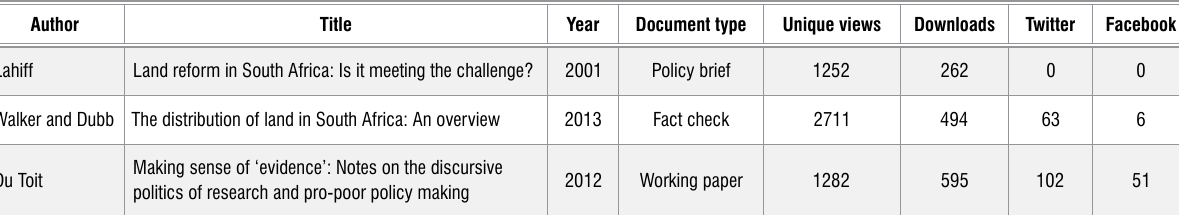
Three PLAAS outputs with high altmetric